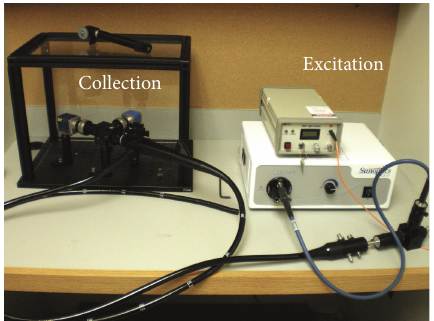
Figure 1: Schematic and photograph of dual channel clinical fluorescence